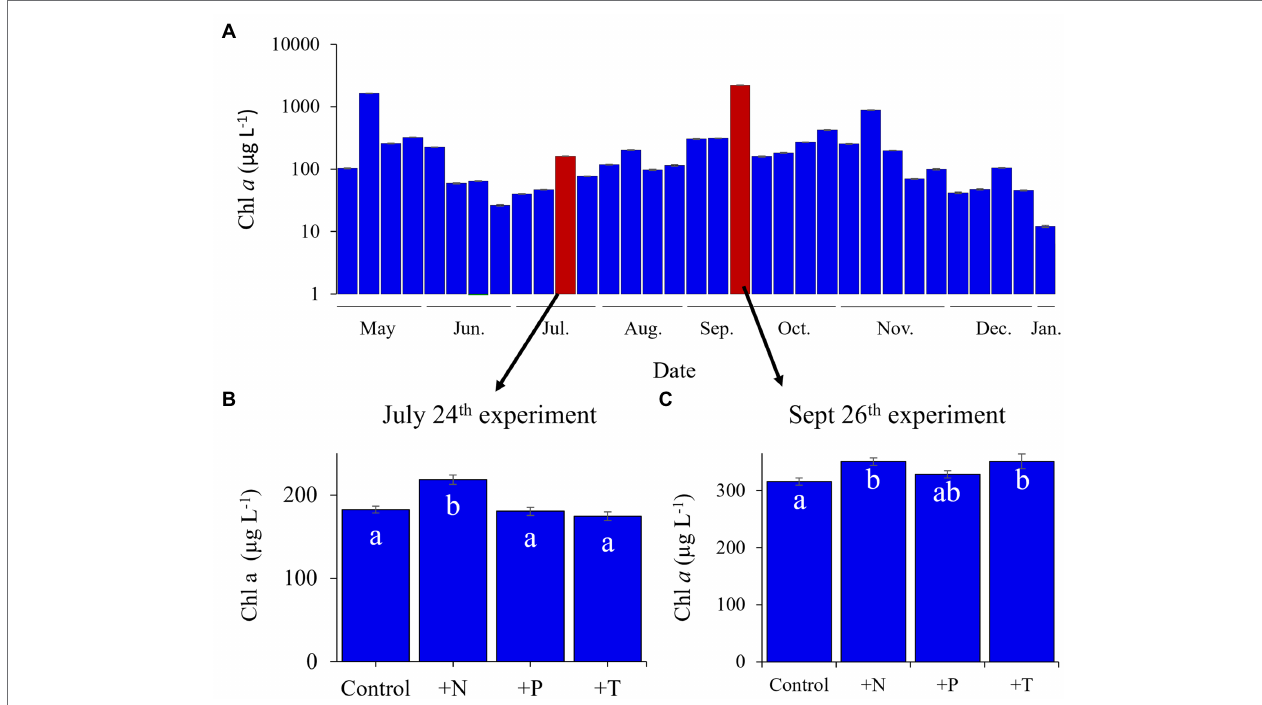
FIGURE 1 | Lake Agawam phytoplankton community dynamics in 2017 determined via fluoroprobe. (A) Cyanobacterial dynamics throughout the monitoring period with highlighted bars representing experimental dates. Fluorometrically derived phytoplankton abundances in response to the experimental treatments (CTR, Control; +N, Nitrate addition; +P, Orthophosphate addition; +T, elevated incubation temperature) in the (B) July 25th and (C) the September 26th experiments. Letters indicate significant differences in cyanobacteria abundances between treatments, bars with shared letters are not significantly different. Note the September 26th experiment was conducted with lower density bloom water than the monitoring sample (collected south of the monitoring